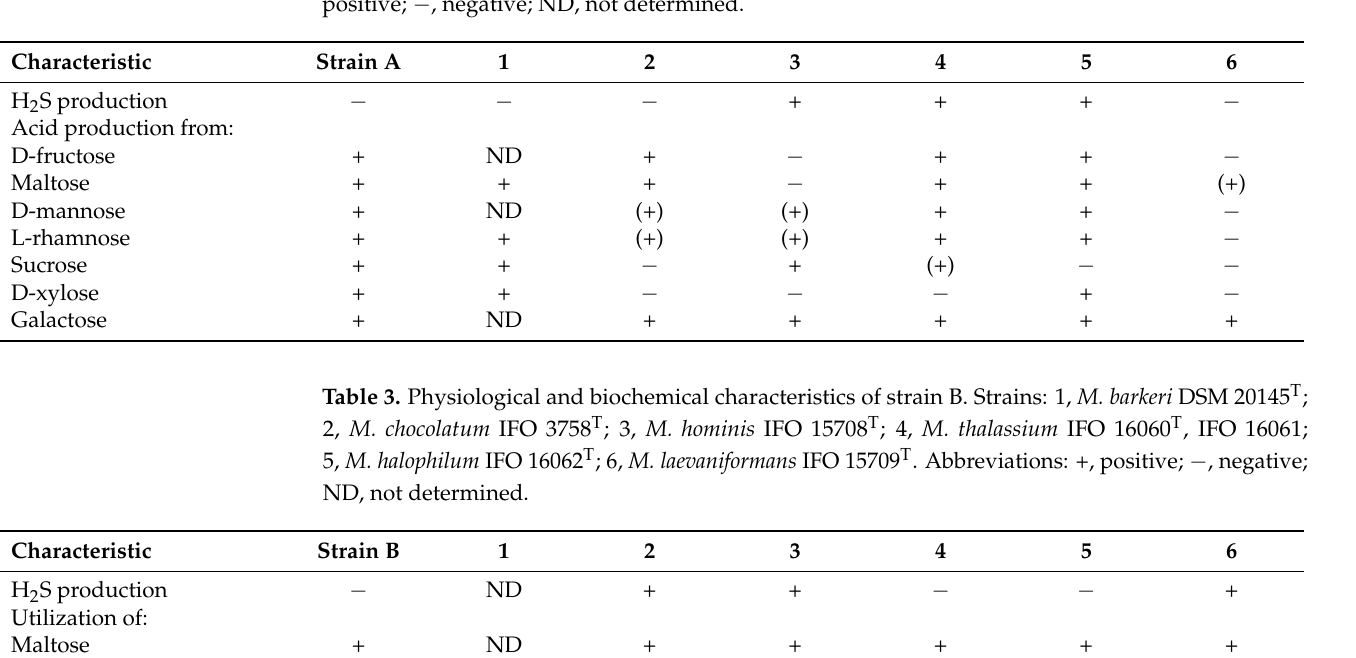
Table 2. Physiological and biochemical characteristics of strain A. Strains: 1, B. phenoliresistens LMG 23707 T ; 2, B. saceli DSM 14566 T ; 3, B. alimentarium CCM 4520 T ; 4, B. freconis DSM 14564 T ;